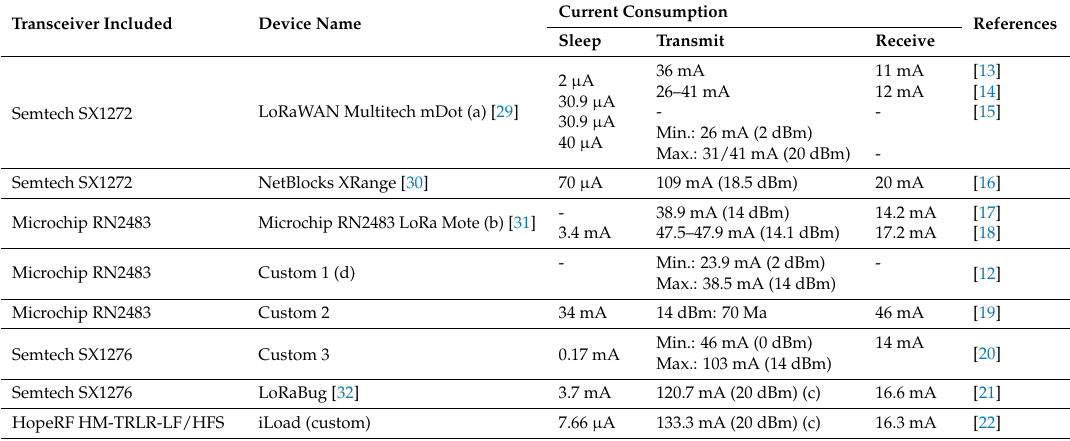
Table 1. Current consumption of LoRa/LoRaWAN nodes considered in the literature. When available, transmit power is shown between parentheses next to each corresponding current consumption value in transmit state. Notes: (a) The transmit power consumption setting is not detailed in these papers; we have included datasheet values. (b) A datasheet with power consumption details for this product appears not to be available. (c) The paper does not explicitly indicate the transmit power. We have deduced it based on the current consumption measured (see Table 2). (d) Data are derived from a figure related to power consumption.